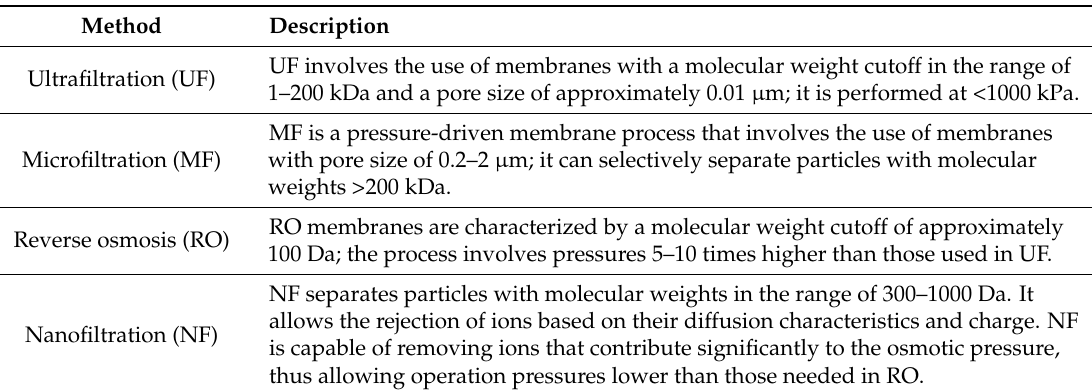
Table 4. Brief general descriptions of membrane